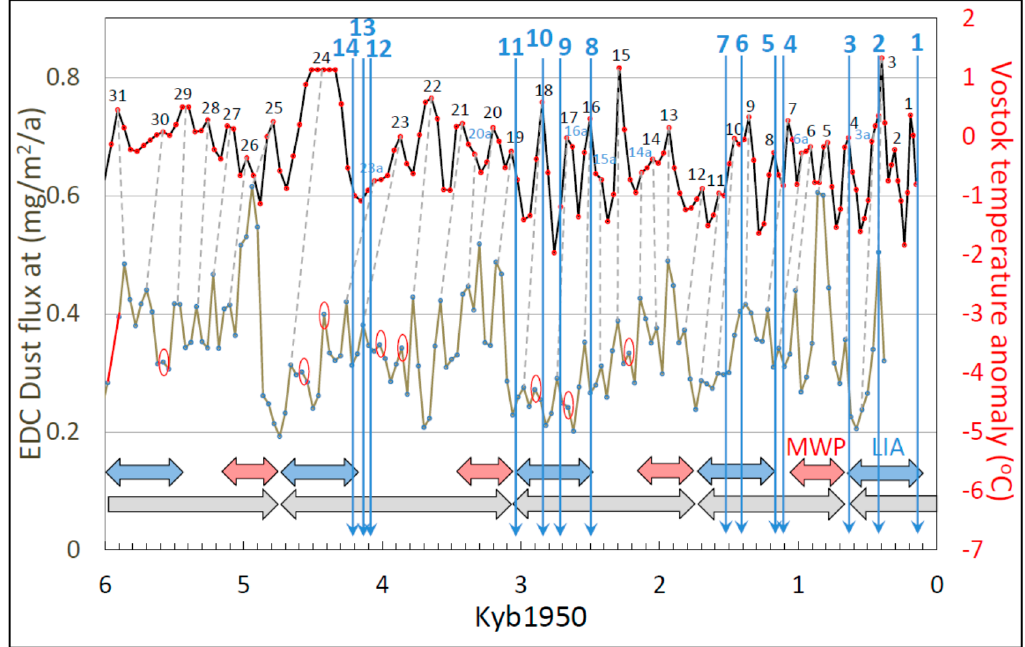
Figure 7. As in Figure 6, but with superimposed dates of civilizational collapses [25,31,32] indicated by numbered vertical blue arrows. The 20 largest human civilizations of the past six millennia collapsed during or near the Little Ice Age (LIA) or one of its recurrent precursors (blue double headed arrows near bottom of graph). Numbered vertical blue arrows designate the date of severe droughts and/or the collapse of identified civilizations as follows: 1, Second Persian Empire (Safavid Dynasty)